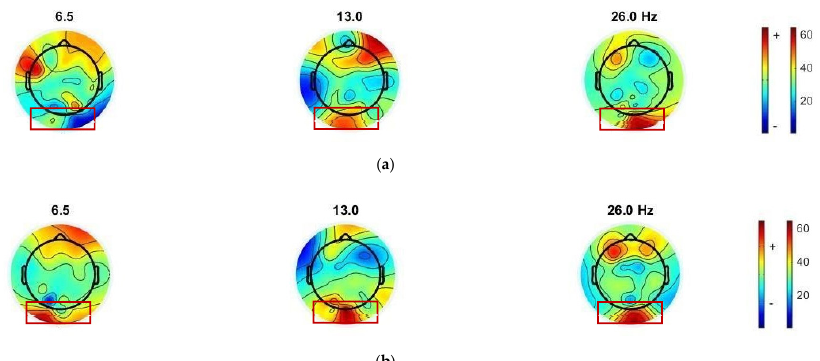
Figure 8. Topographic brain mapping of SSVEP responses of participant 3: ( a ) SSVEP visual stimulation, using the checkerboard pattern and mixing fundamental flicker frequency at 13 Hz and sub-harmonic frequency at 6.5 Hz; ( b ) SSVEP visual stimulation, using the QR code pattern and mixing fundamental flicker frequency at 13 Hz and sub-harmonic frequency at 6.5 Hz.